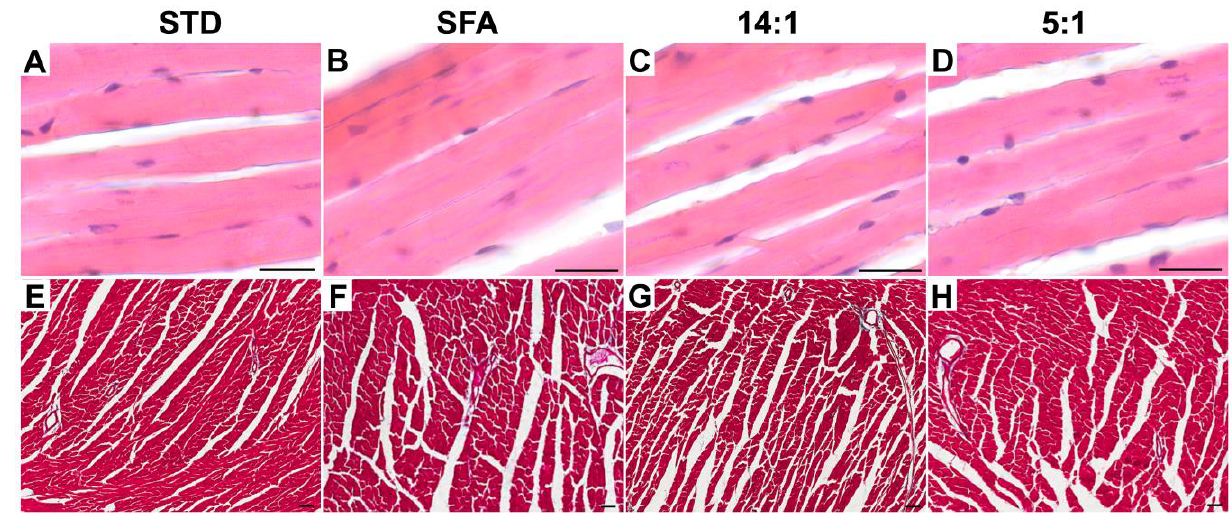
Figure 1. Representative light micrographs of H&E-stained ( A – D ) and Mallory’s trichrome-stained ( E – H ) ventricle mid- region heart cross sections after STD (( A ), ( E )), SFA (( B ), ( F )), 14:1 (( C ), ( G )) and 5:1 (( D ), ( H )) diets. Scale bar—50 µm. STD – standard diet; SFA – high fat diet rich in saturated fatty acids; 14:1 – high fat diet rich in polyunsaturated fatty acids (PUFA) with LA/ALA ratio ~14:1; 5:1 – high fat diet rich in (PUFA) with LA/ALA ratio 5:1.